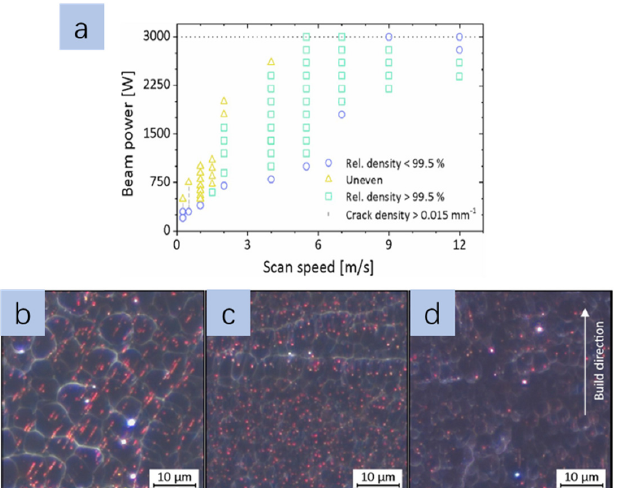
Figure 15. ( a ) High oxygen content powder at a process temperature of 530 °C; ( b – d ) Light micro ‐ scope pictures in dark ‐ field mode showing the Cu2O distribution. ( b , c ): set II with cracks, ( d ): set I without cracks. Reproduced with permission from [28] Elsevier, 2020.